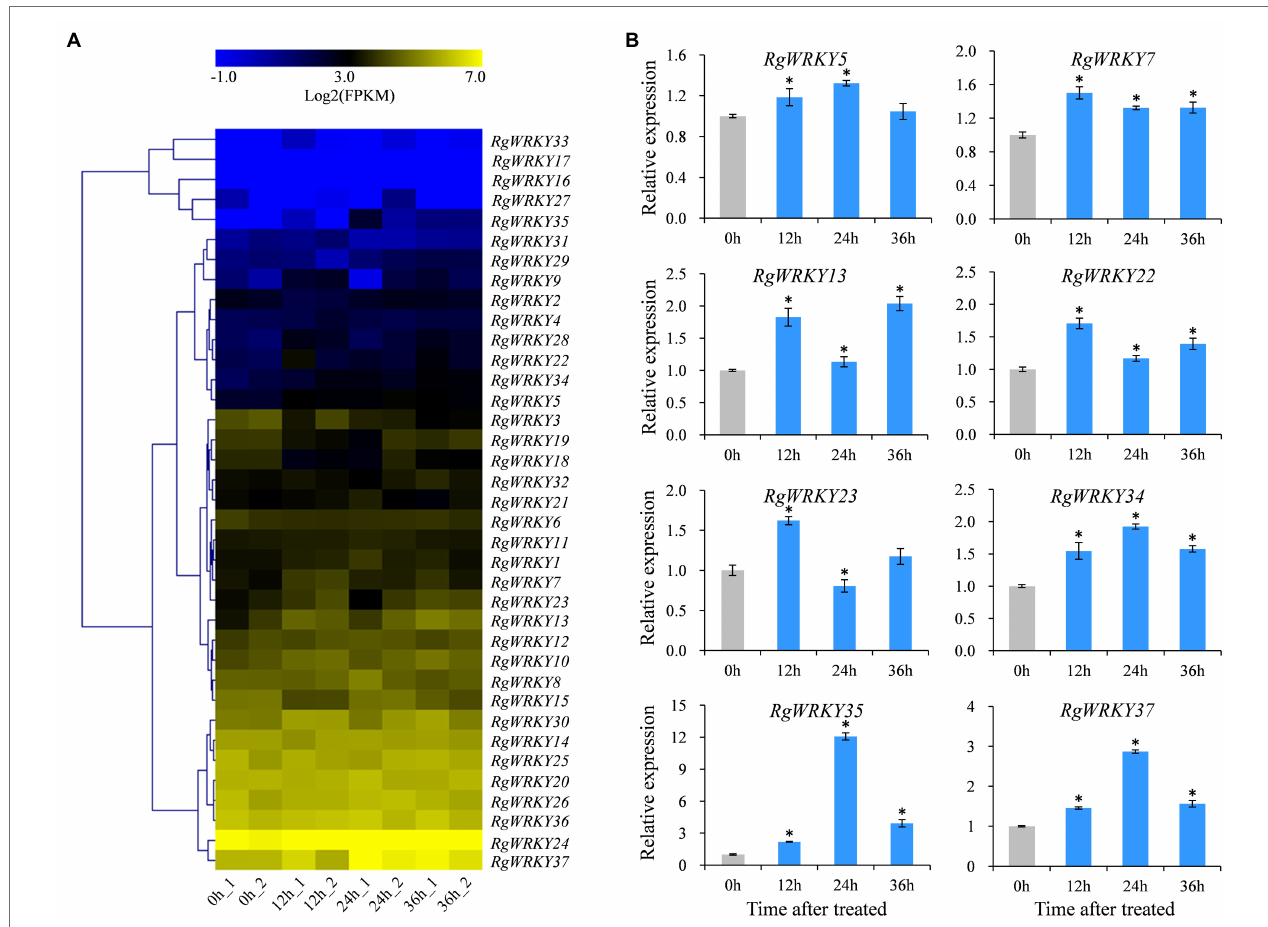
FIGURE 5 | Expression profiles of 37 WRKY genes in R. glutinosa hairy roots after H 2 O 2 treatment. (A) Heat map representing expression dynamics of WRKY genes after H 2 O 2 treated. (B) Relative expression levels of eight WRKY genes in hairy roots after H 2 O 2 treatment by qRT-PCR. The asterisks indicate statistically significant differences at p <